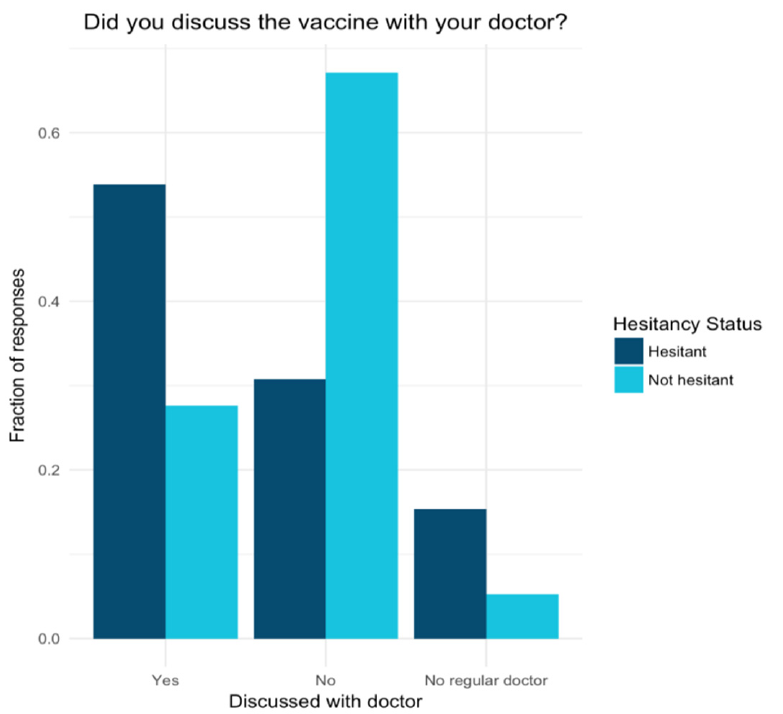
Figure 3. Hesitant and not hesitant group comparisons of whether they discussed the vaccine with a doctor.